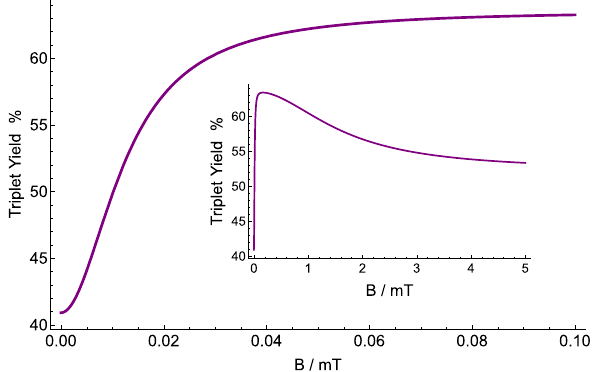
Figure 2. The dependence of the triplet yield of the [ TrpH . + . . . O2 . − ] complex on applied static magnetic field for r = 10 5 s − 1 , k = 10 6 s − 1 , a A = 1.6046 mT. The triplet yield goes from around 60% to around 40%